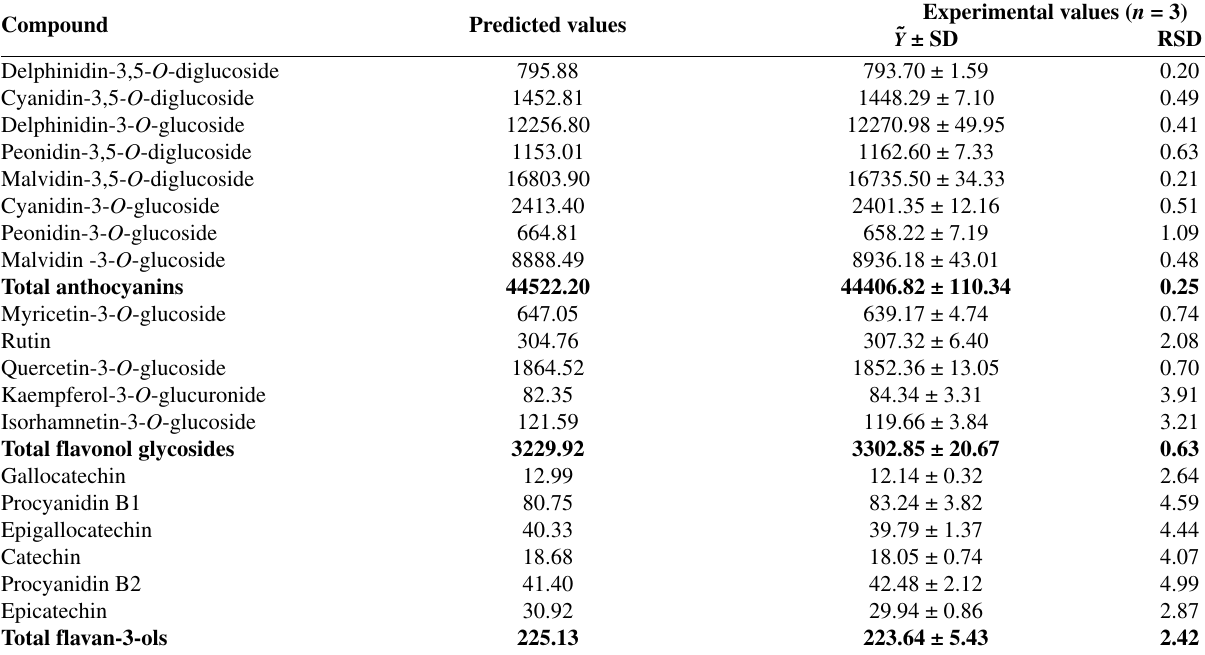
Table 4. The content of individual flavonoids extracted from grape skins by using optimal conditions. Results are expressed in mg kg –1 dry weight of grape skin